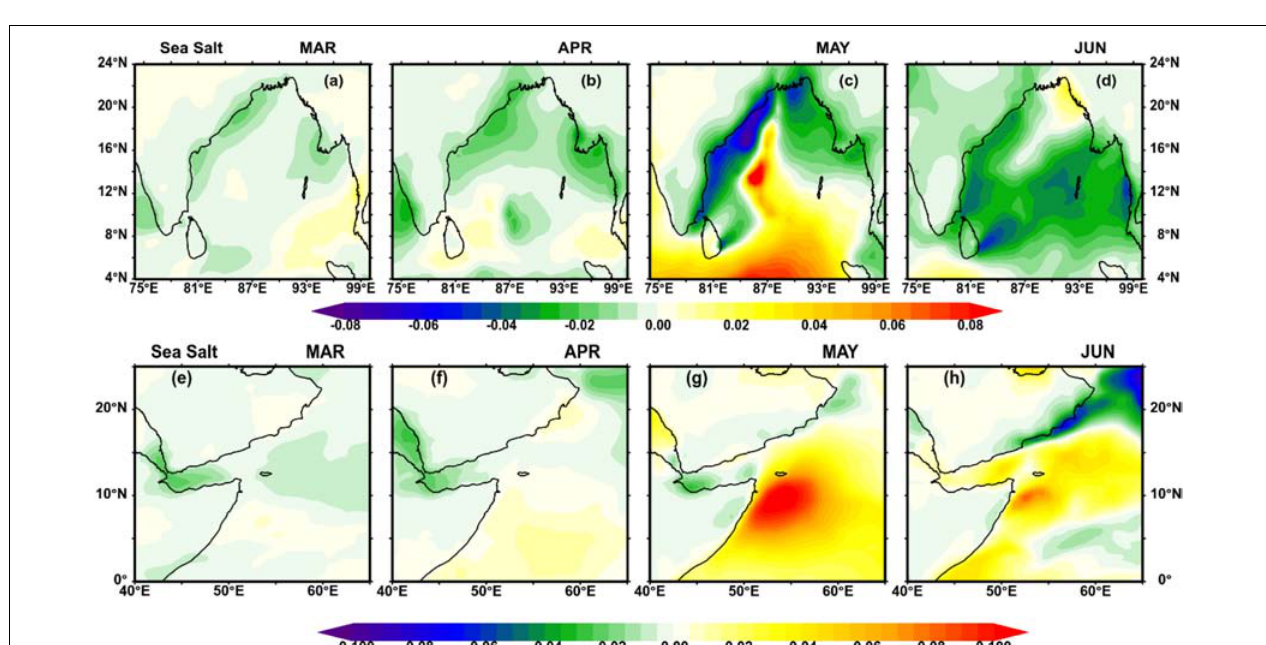
FIGURE 8 | Difference (pandemic – pre-pandemic) in sea salt concentration ( × 10 - 6 kg m - 3 ) over the BoB (A–D) and WAS (E–H) .